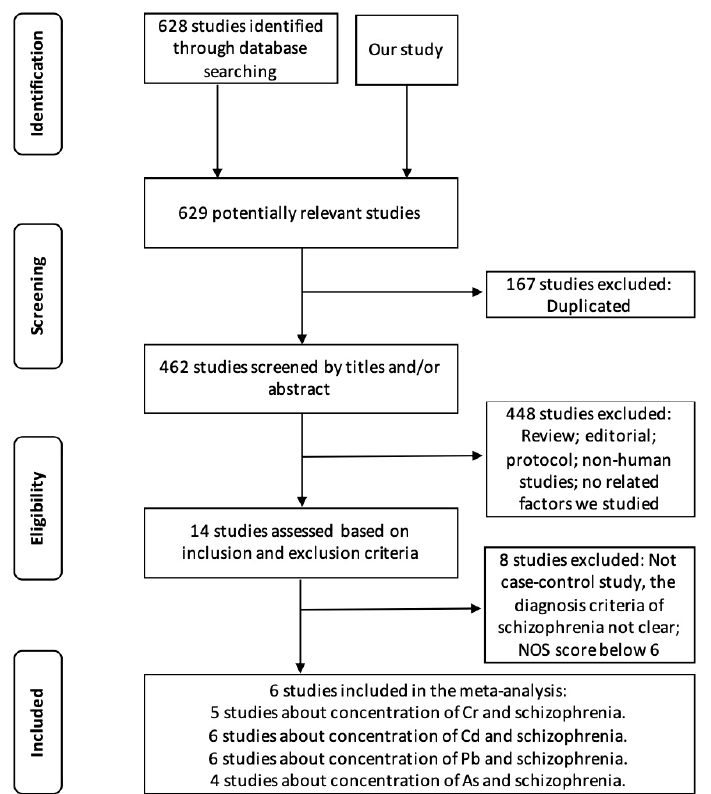
Figure 1. Flow diagram of the studies selection process for the present meta-analysis.